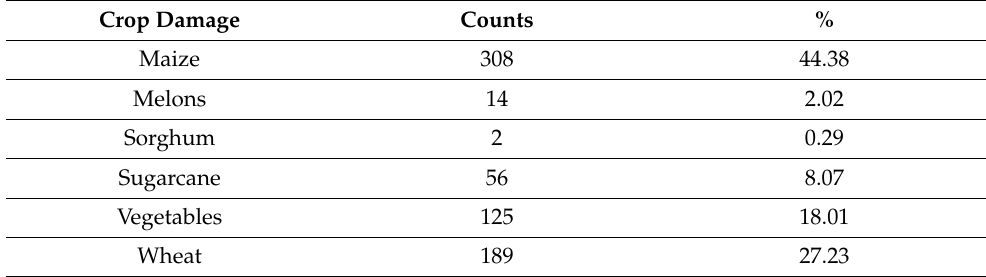
Table 3. Crop damage ( n = 694) by wild boars used in the crop damage-based PCA. The values indicate the number of crop damages for each level (counts) and the percentages (%) for each categorical factor used in the crop damage-based PCA.